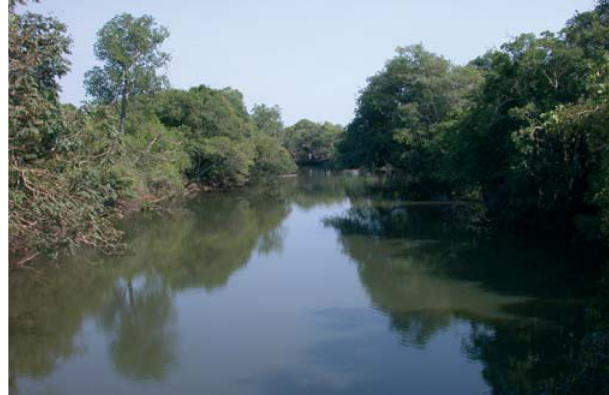
Fig. 11. Type locality of Ituglanis macunaima , corixo da Saudade (14 o 17’20.6"S 51 o 09’12.1"W); Brazil, Mato